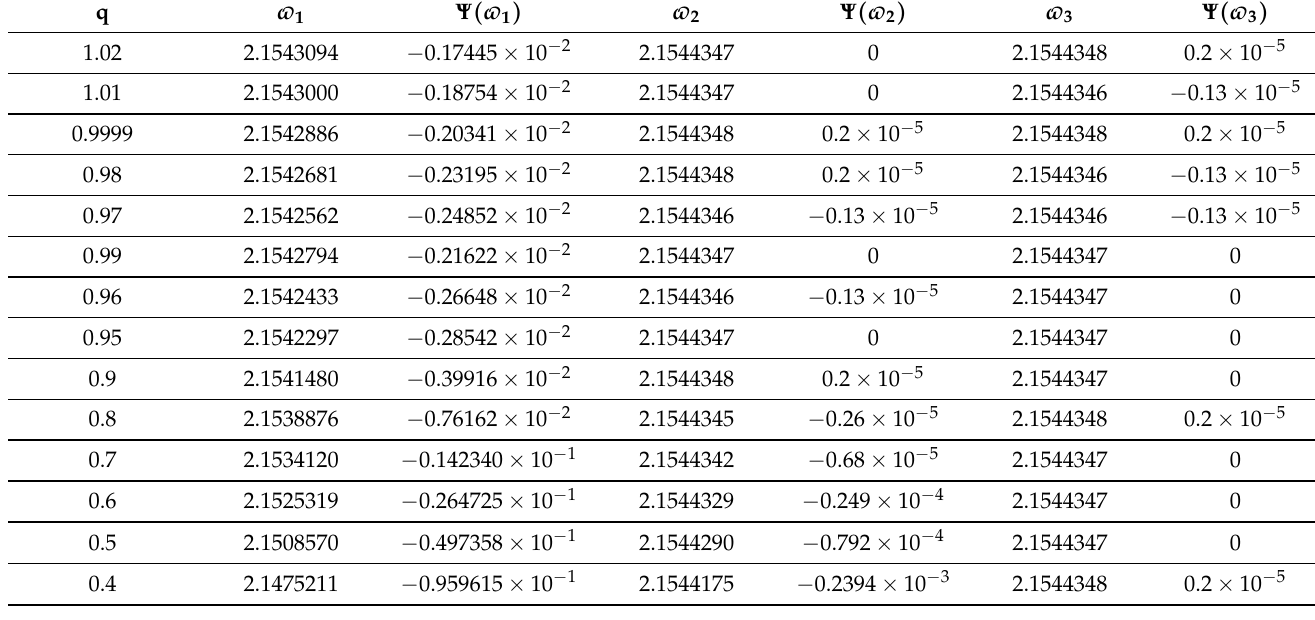
Table 2. Calculation of (cid:118) i and Ψ ( (cid:118) i ) for i = 1,2,3 and different values of q by using QAG2.